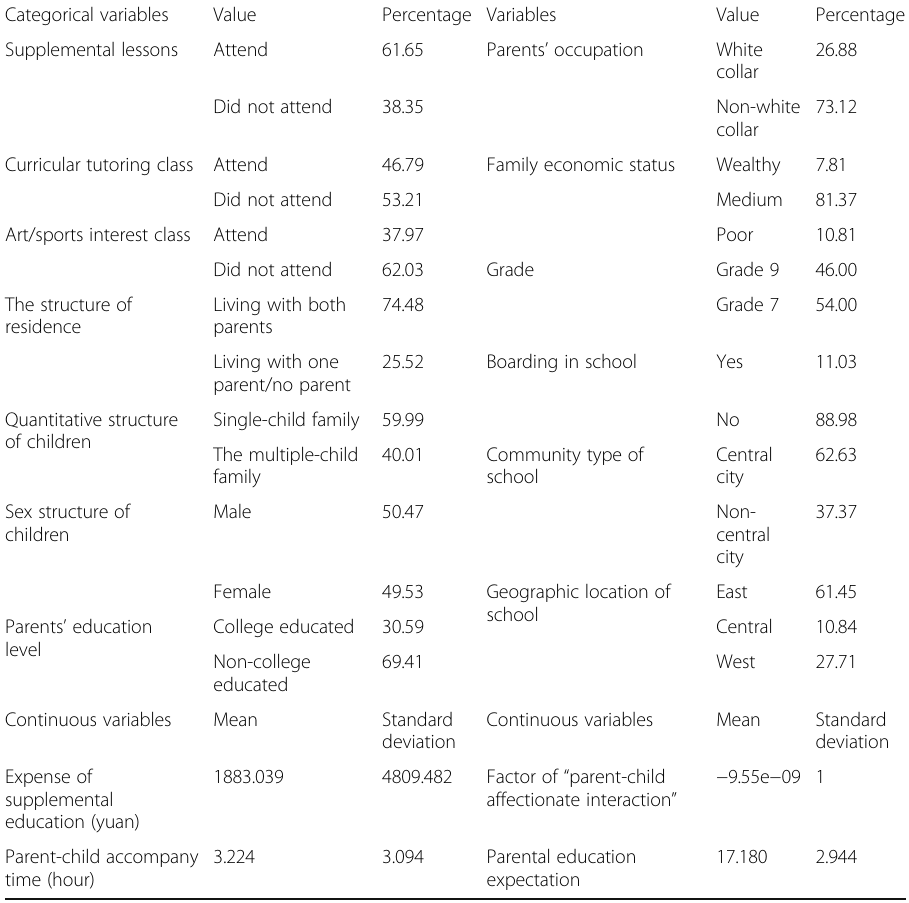
Table 1 Basic information for major variables N = 9272 Categorical variables